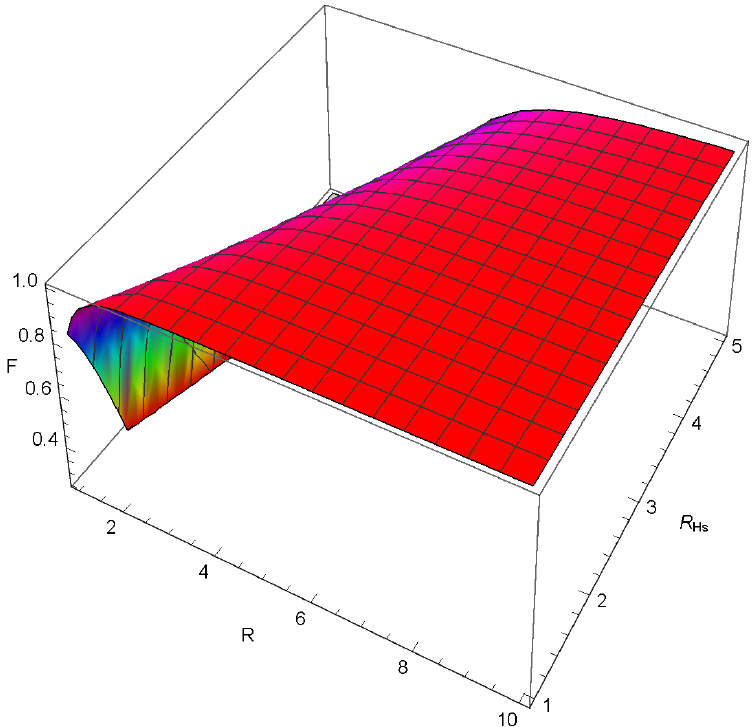
Figure 20. Solution of F ( R ) for p = 3. The evolution of the partial derivative of f ( R ) is obtained using Equations (33) and (41).